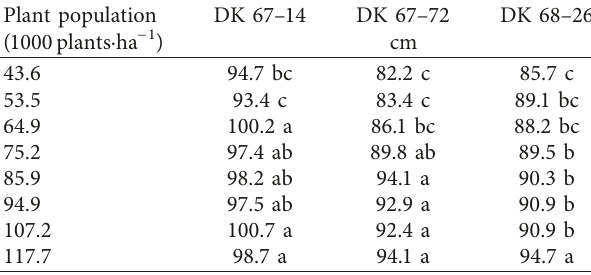
Table 3: Corn ear height of the three hybrids with various plant populations over the two